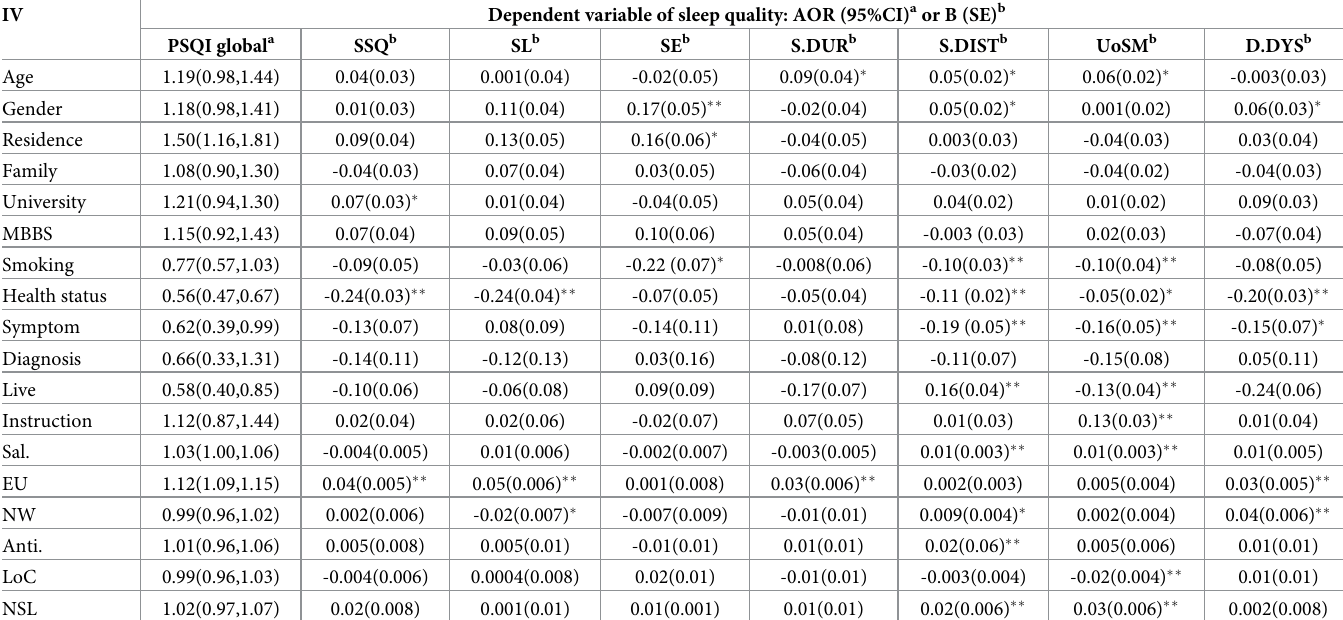
Table 4. Predictors on sleep quality (N =